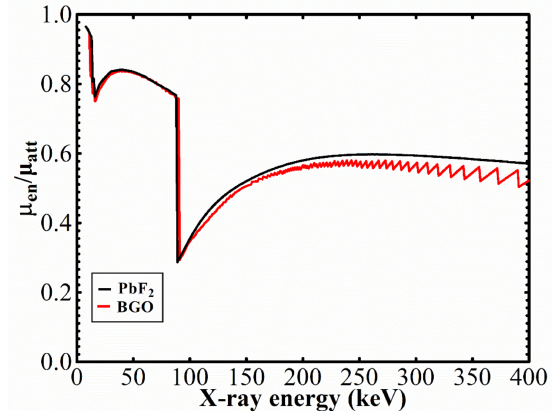
Figure 2. Attenuation coefficients ratio µ en / µ att of PbF 2 and